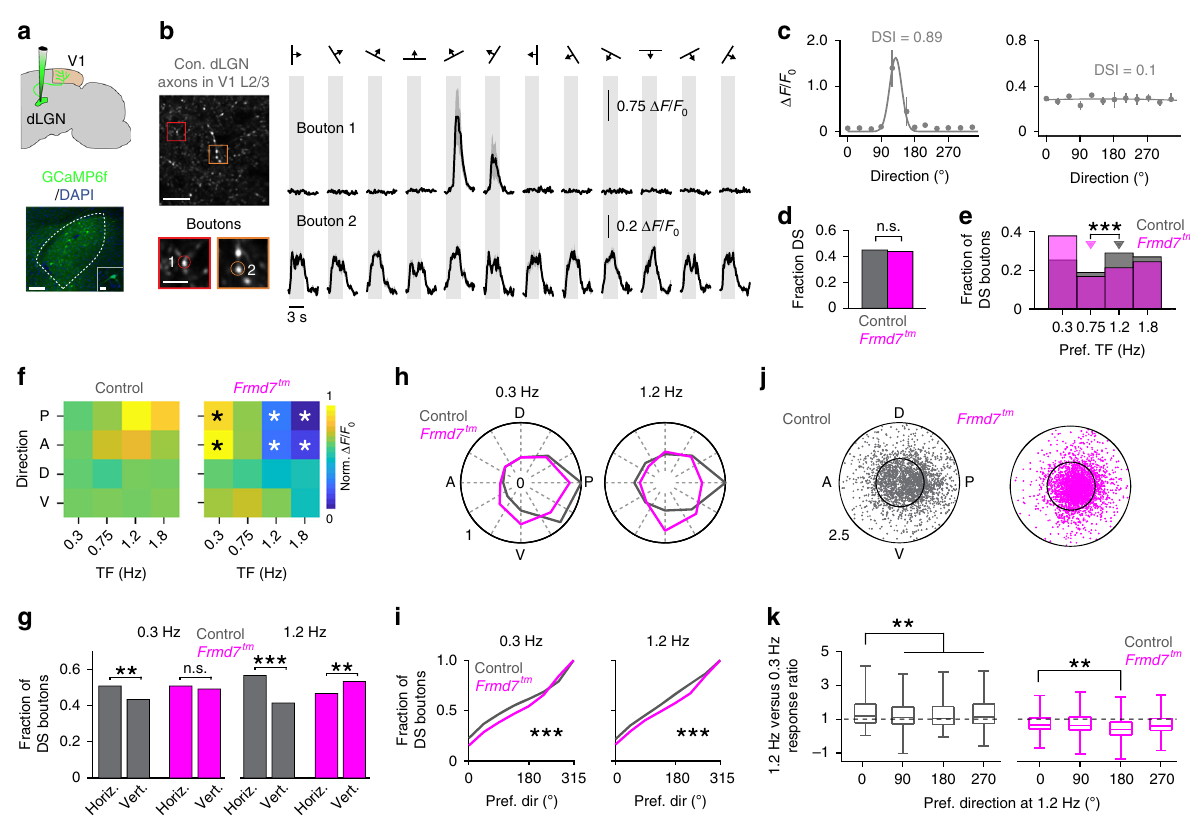
Fig. 6 Directionally tuned thalamic boutons in the super fi cial V1 are sensitive to disruption of retinal horizontal direction selectivity. a Top: thalamocortical axons in V1 were labeled by injecting AAV2/1-GCaMP6f into the dLGN. Bottom: Example GCaMP6f-positive neurons in dLGN (scale bar, 100 µ m; inset, 10 µ m). b Left top: Example two-photon image of dLGN axons in L2/3. Left bottom: magni fi ed axonal boutons expressing GCaMP6f (scale bar, 35 µ m; inset, 10 µ m). Right: trial-averaged fl uorescence ( Δ F / F 0 ) time courses for the boutons indicated. Shading: SEM. c Tuning curves for boutons shown in b . Error bars: SEM. Solid line: Gaussian fi t. d Fraction of DS boutons (5,121 and 5,525 DS boutons from control and Frmd7 tm mice, respectively; fi ve mice per group; two-sided χ 2 test with Yates correction). e Preferred TF for DS boutons (two-sided Mann – Whitney U- test). Triangles: Medians. f Response amplitude as a function of motion direction and TF for DS boutons. White and black asterisks: signi fi cantly decreased and increased responses, respectively, in Frmd7 tm mice, P < 0.05, two-sided Mann – Whitney U -test. g Fraction of horizontally- and vertically tuned DS boutons at 0.3 and 1.2 Hz (two- sided χ 2 test with Yates correction). h Fractional distributions of preferred motion directions for DS boutons at 0.3 and 1.2 Hz, normalized to the largest fraction across genetic groups. i Distribution of preferred motion directions at 0.3 and 1.2 Hz in DS boutons (two-sided Kolmogorov – Smirnov test). j TF- dependent characteristics of DS boutons. Angular coordinate: Directional preference at 1.2 Hz. Radial coordinate: Ratio of response amplitudes at 1.2 and 0.3 Hz. Inner circle: Response ratio of 1. k Ratio of response amplitudes at 1.2 and 0.3 Hz as a function of motion direction preference of DS boutons (two- sided Mann – Whitney U -test). Center line is median, box limits are 25th and 75th percentiles, and whiskers show minimum and maximum values. * P < 0.05, ** P < 0.01, *** P < 0.001, n.s., not signi fi cant. Source data are provided as a Source Data fi